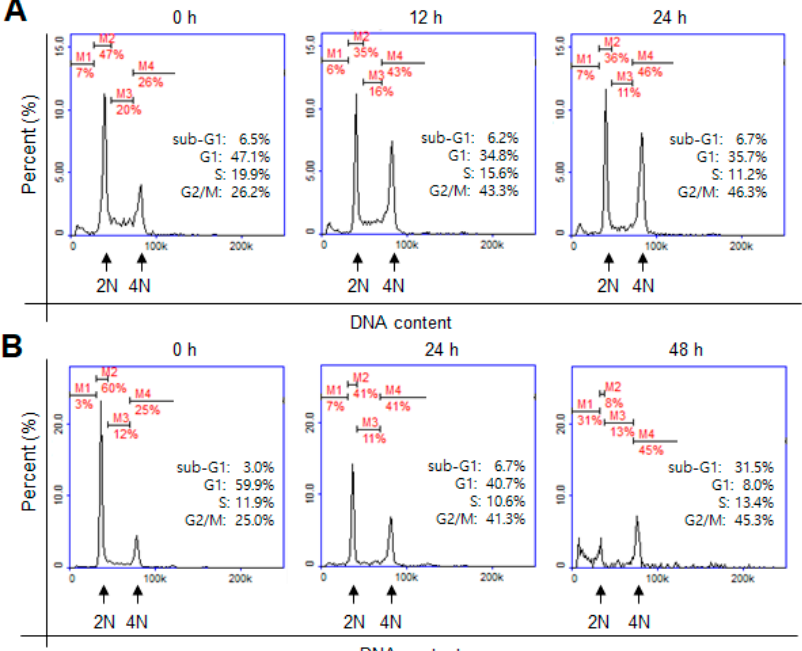
Figure 5. Effect of derivative 31 on G2/M arrest and apoptosis. HCT116 cells were treated with 5 µ M derivative 31 for 0, 12 and 24 h ( A ) or 0, 24 and 48 h ( B ). The cells were fixed with ethanol and stained with propidium iodide (PI). Cellular DNA contents were determined by flow cytometry. 2N, diploid; 4N, tetraploid; M1, sub-G1; M2, G1; M2, S, M4,